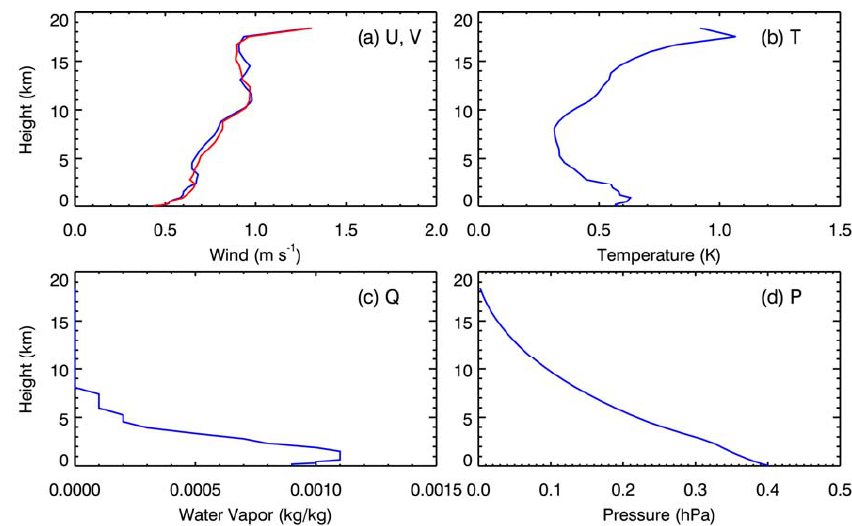
Figure 2 Fig. 2. Vertical distribution of the initial ensemble spread for (a) horizontal winds ( u , v , m/s), (b) temperature ( T , K), (c) pressure ( p , hPa), and (d) water vapor mixing ratio ( q , g/kg) over domain